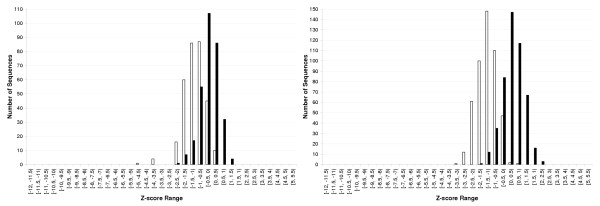
Distribution of single sequence z scores for 5S rRNA, tRNA, and negative sequences. Distributions of RNAstructure-predicted z scores computed on the basis of folding single sequences for 5S rRNA and negatives generated from them (left figure) and tRNA and negatives generated from them (right figure). Real ncRNA are white, negatives are black. Controls were generated by the Altschul-Erikson dinucleotide shuffle of original sequence, with 100 controls for each test set sequence. 309 5S rRNA sequences and 482 tRNA sequences, plus one negative sequence generated from each real sequence by the Altschul-Erikson shuffle, were used for the test set.